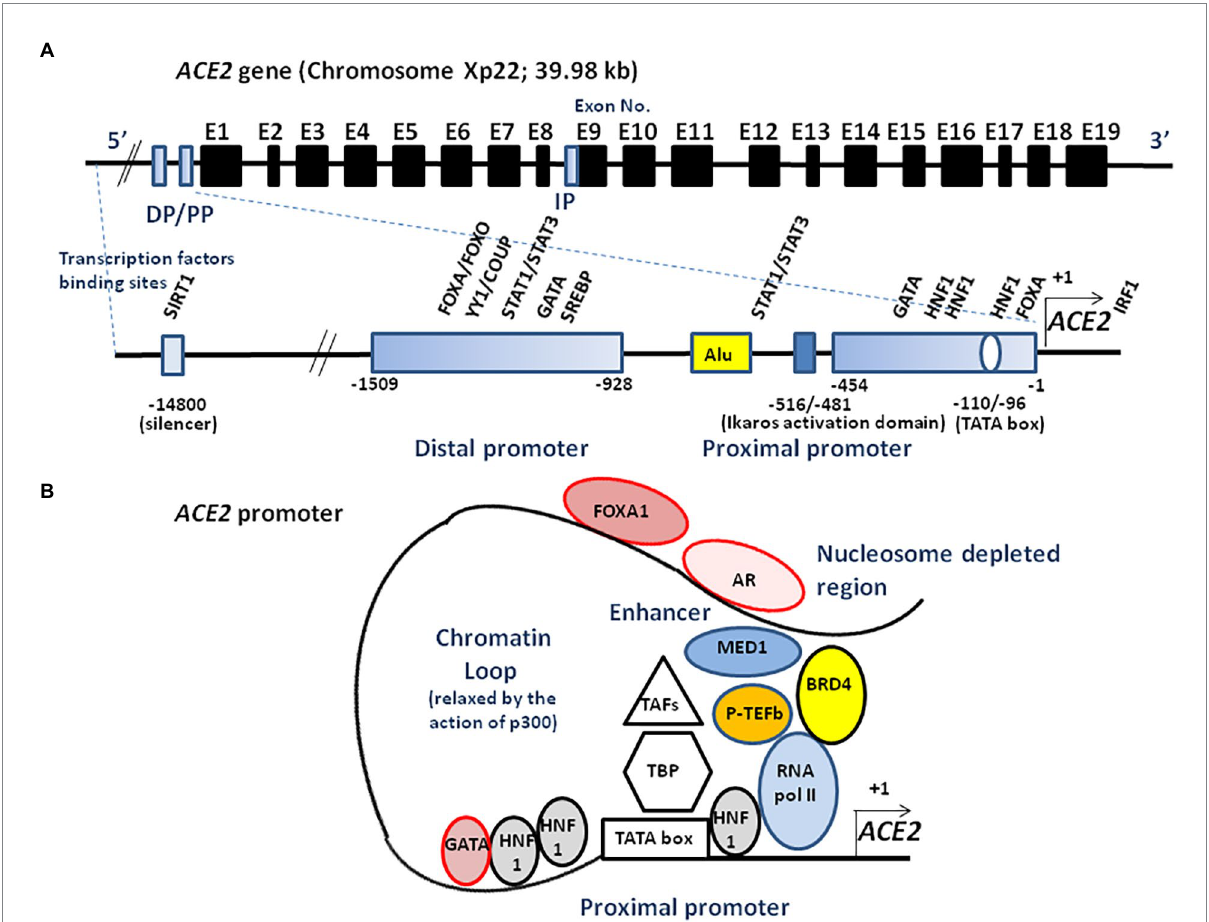
FIGURE 3 Schematic illustration of ACE2 transcriptional regulation. (A) A schematic diagram of the ACE2 gene structure (upper panel). The known exons (E1–E19) are depicted as black boxes. The location of the distal promotor (DP) and proximal promoter (PP) are depicted as blue boxes. The ACE2 gene can encode several transcript leading to several isoforms. An internal promoter (IP) is thought to activate the transcription of an mRNA encoding a short isoform of ACE2 which lacks the SARS-CoV-2 binding site. The 5 ′ region upstream of the ACE2 gene contains two promoters (proximal and distal) separated by a repetitive Alu element (lower panel). The transcription of full-length ACE2 is initiated from either the proximal or distal promoter with tissue-specific differences in their usage. Transcription factors binding to the proximal and the distal upstream promoter regions are indicated. Ang II is likely to regulate the ACE2 expression through the Ikaros activation domain. Truncated ACE2 forms (e.g., dACE2 ) can also be expressed. (B) ACE2 transcriptome. AR binds to the enhancer element of the ACE2 gene, connecting the regulatory circuit between the enhanceosome complex (comprising MED1, BRD4, etc.) and the promoter-bound RNA polymerase machinery to activate gene expression. P-TEFb, positive transcription elongation factor; TBP, TATA-binding protein; TAFs, TBP-associated factors; FOXA1, forkhead box A1;